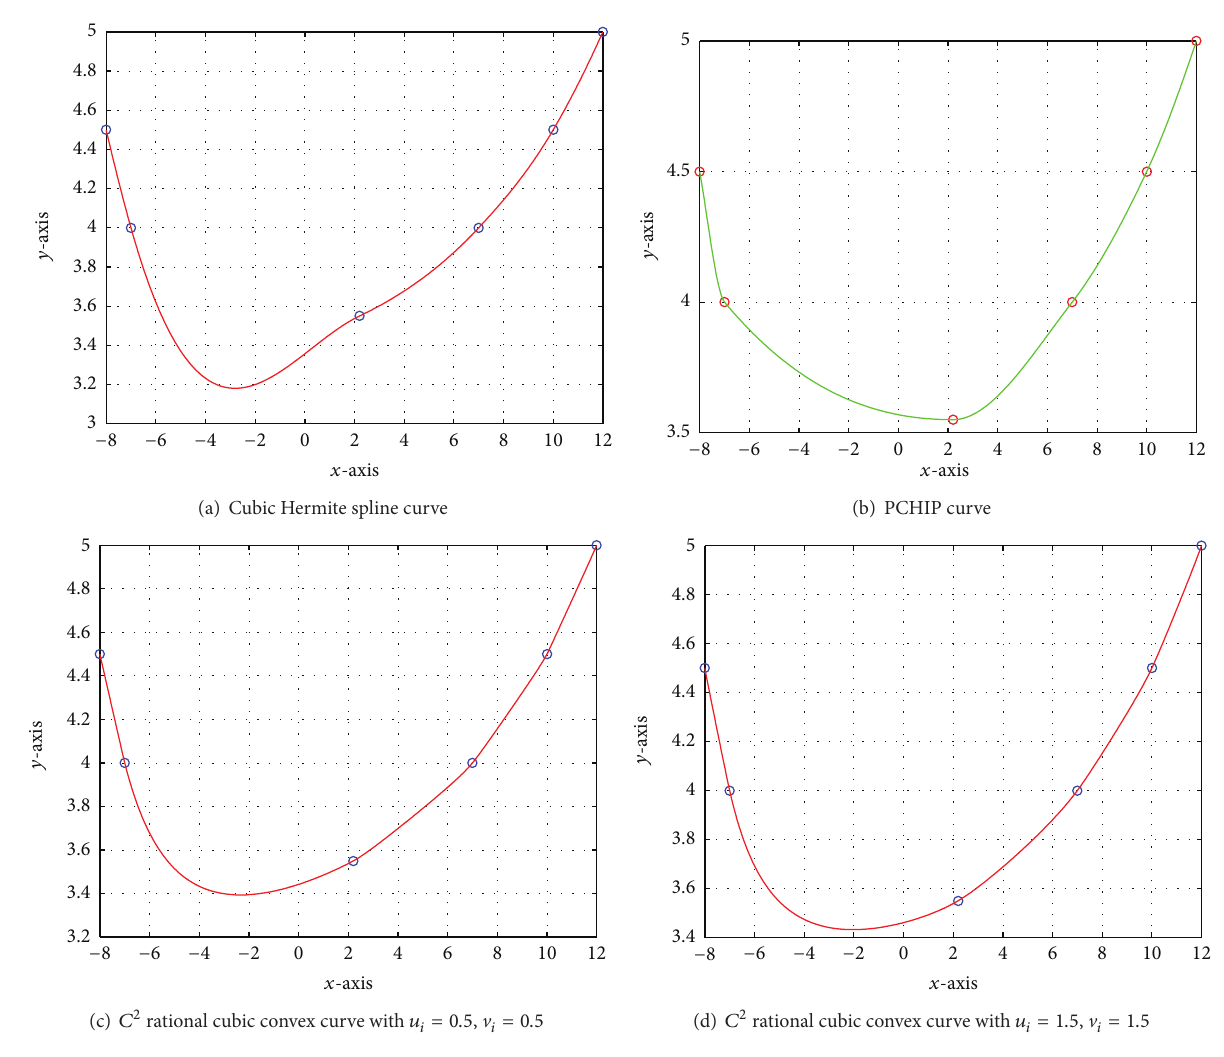
Figure 4: Comparison of convex and nonconvex curves through given 2D convex data.